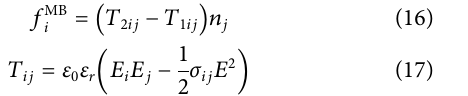
Frontiers in Physics |